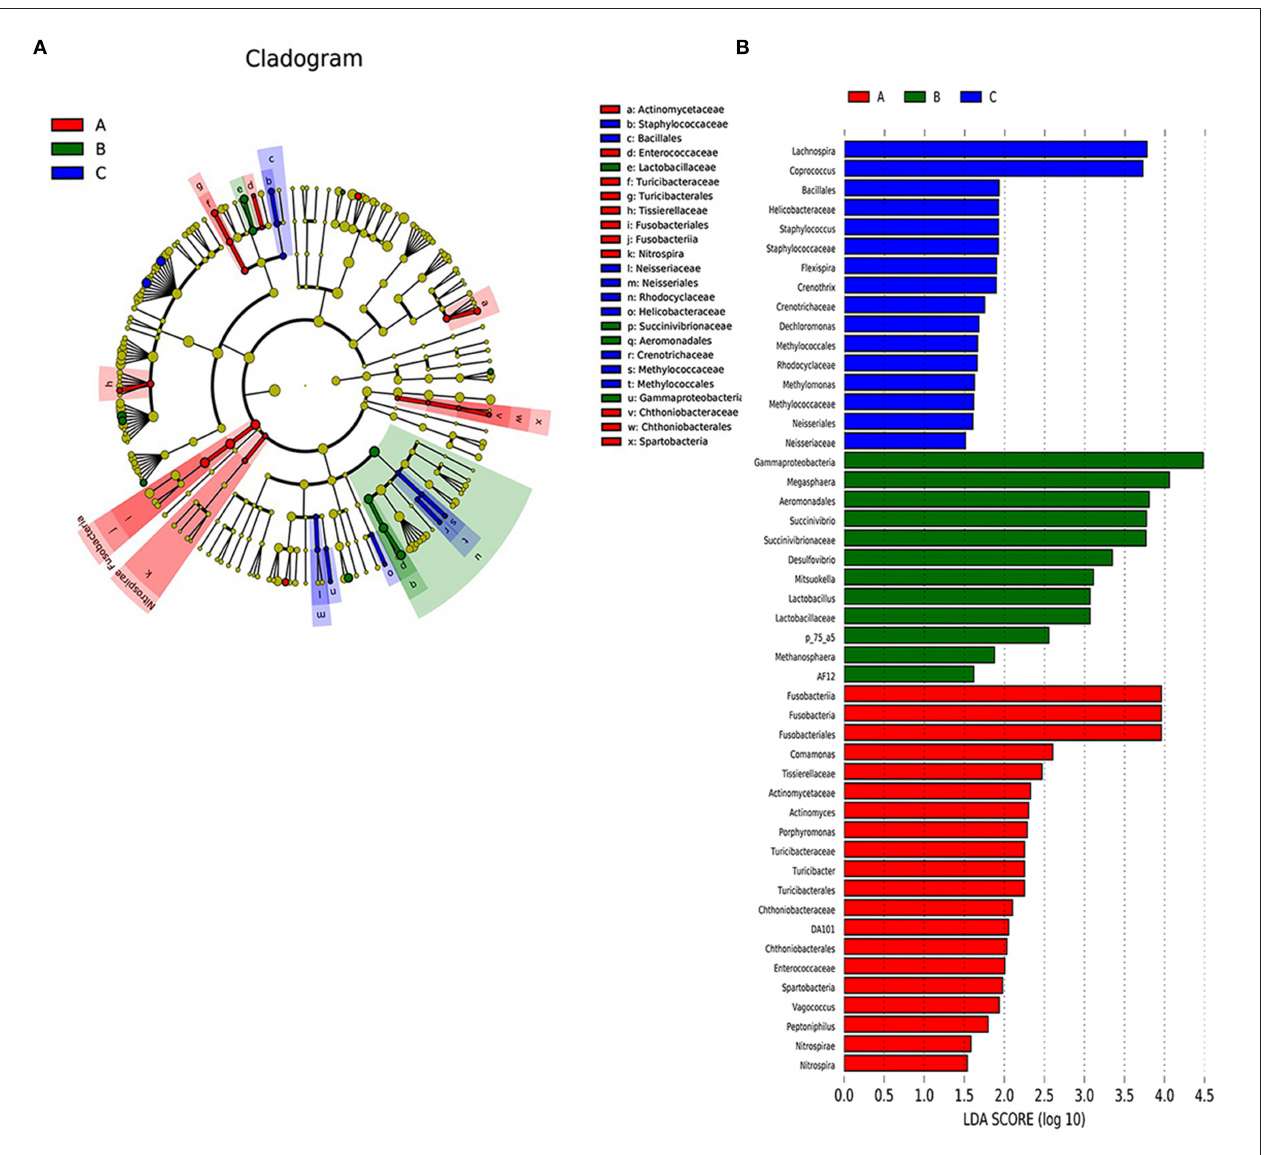
FIGURE 3 | The differently abundant taxa identified using LEfSe analysis. (A) LEfSe clagogram showed the most differentially abundant taxa among the groups. Taxa enriched for health group in blue. Acute set stage group enriched taxa in red. Remission group enriched taxa in green. The size of each dot is proportional to its effect size. (B) Visualisation of only taxa meeting an LDA threshold > 2. Taxa with enriched levels in onset stage group are shown in red, green represented taxa with enriched levels in remission stage group, blue represented taxa with enriched levels in health